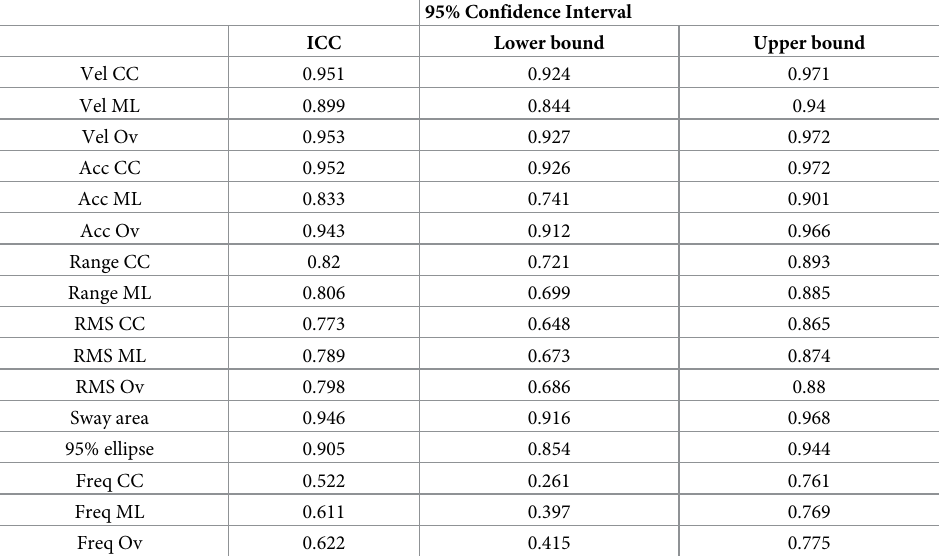
Table 1. Reliability of COP measurements.